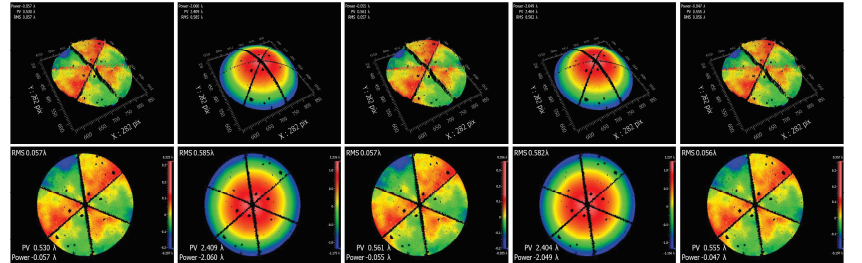
Figure 9. The AR was actuated from the flat state to a less compressed state (or concave surface) and back to flat. For each case the top row is the 3D surface and the bottom row the 2D surface.